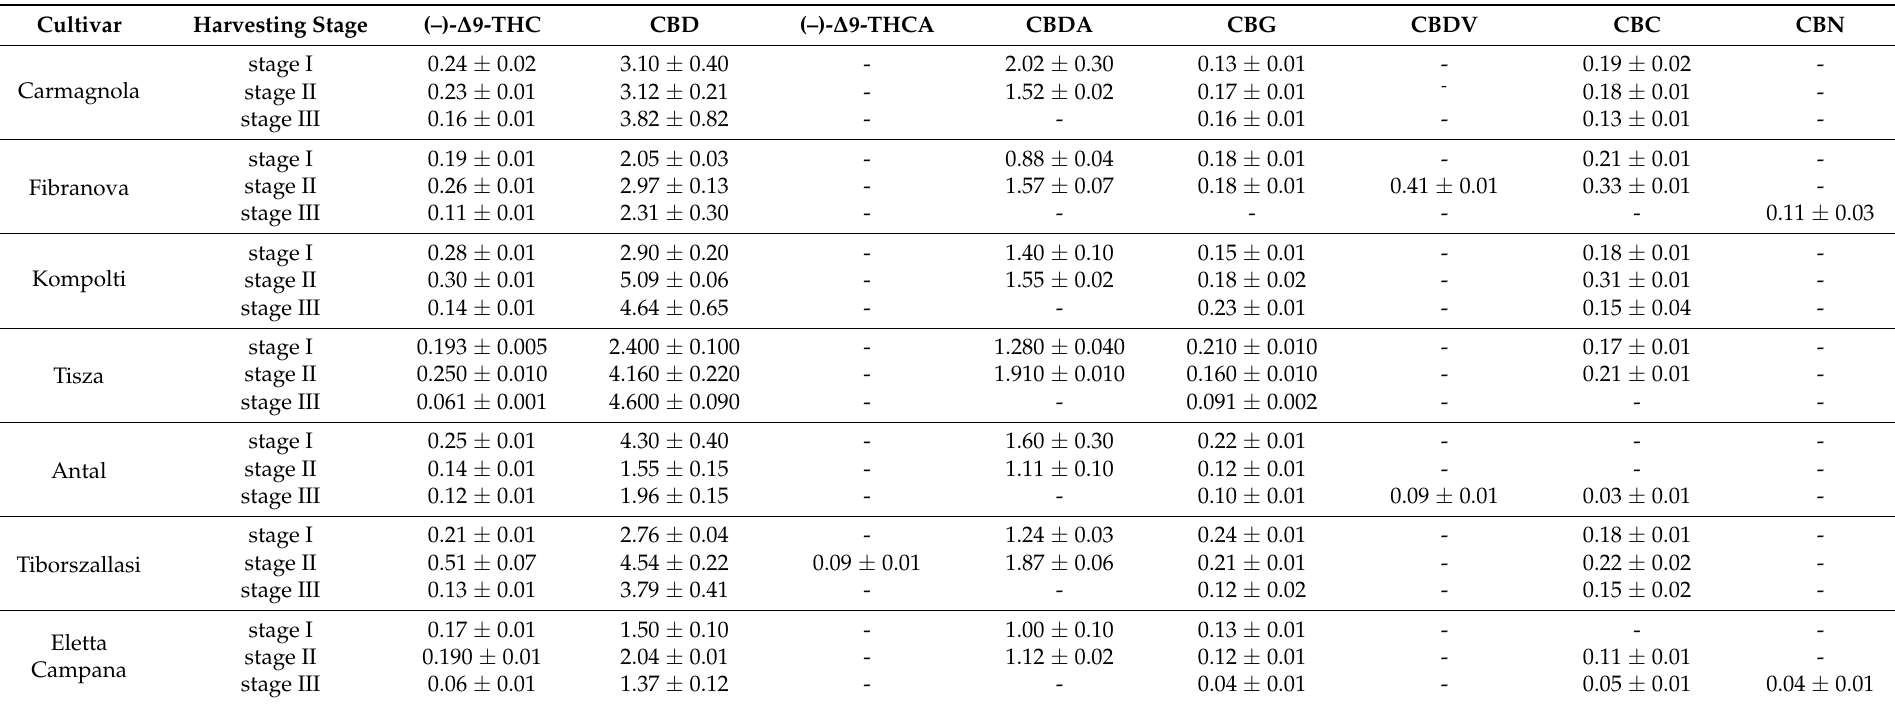
Table 1. Cannabinoid concentrations by ultra-high-performance liquid chromatography (UHPLC analysis (% ( w/w ) ± SD) reported for each cultivar at three harvesting stages (stage I = 4 September, stage II = 14 September, stage III = 30 September). Analyses were carried out in